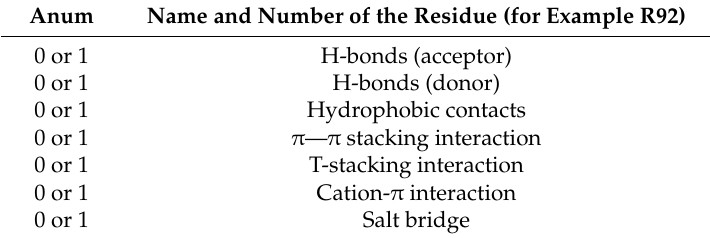
Table 1. Schematic representation of the fingerprint table for the interaction of one ligand with one single